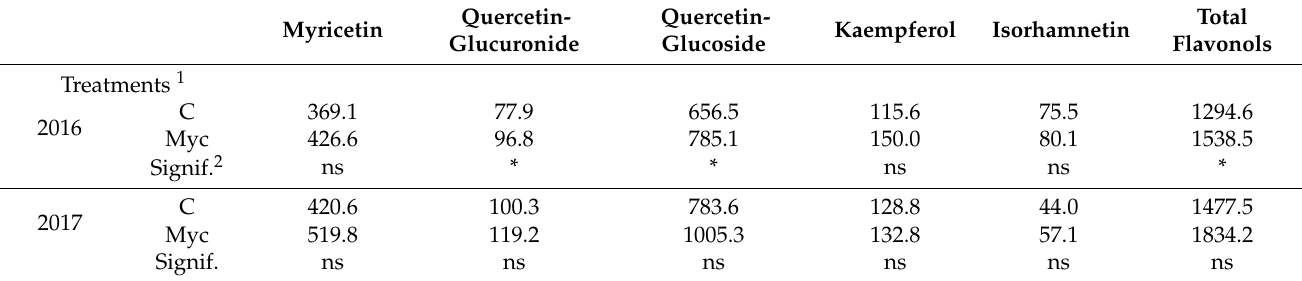
Table 5. Berry skin flavonols (mg kg − 1 of the dry weight of grape skin) in mycorrhized and control